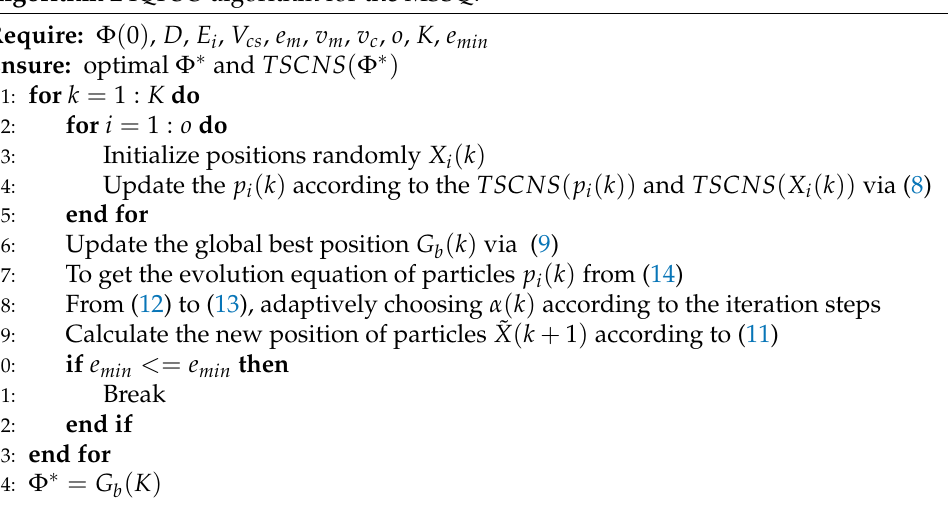
Algorithm 2 IQPSO algorithm for the MSSQ.